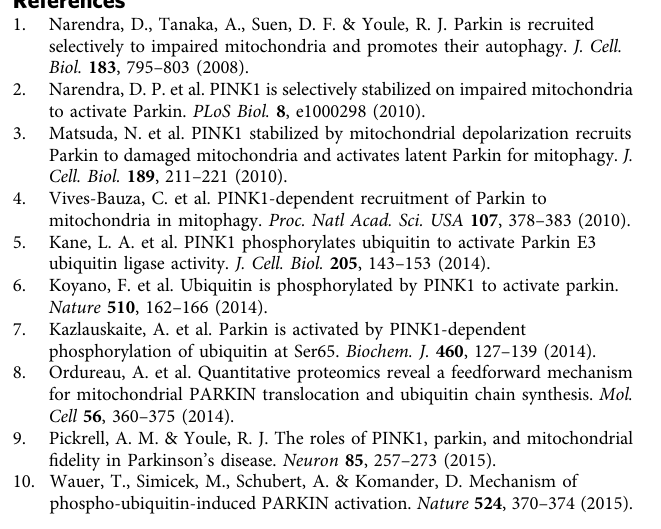
Supplementary Table 1. To simulate the effect of the LIR-mutant NDP52(V136S), the association constants for reactions 13 and 20 were assigned to zero. Statistical calculations . All statistical comparisons were conducted on data ori- ginating from three or more biologically independent experimental replicates (as indicated in fi gure legends), with similar data variances observed between groups. Comparisons between groups were planned prior to statistical testing, and target effect sizes were not pre-determined. No statistical methods were used to determine sample size. All statistical data were calculated and graphed using GraphPad Prism 7. For multi-variable and time-course data, statistical comparisons between groups were performed by two-way ANOVA with post hoc testing by unprotected Fisher ’ s LSD Test. For data representing a single time-point and condition, statistical comparisons between groups were performed by one-way ANOVA with post hoc testing by unprotected Fisher ’ s LSD Test. P values exceeding 0.05 were considered non-signi fi cant. Data availability Plasmids generated during the study are available from AddGene. Additional data that support the fi ndings of this study are available from the corresponding authors upon reasonable